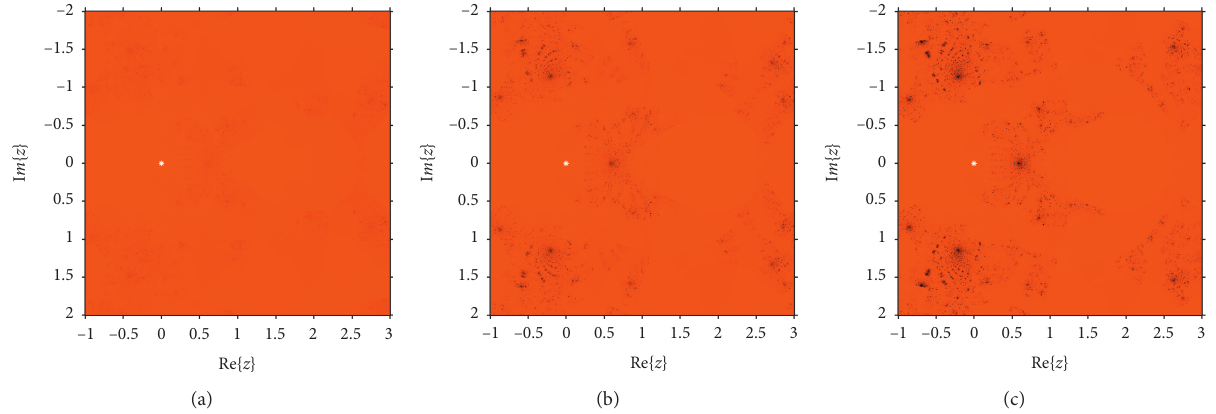
Figure 15: Basins of attraction of (a) BM1, (b) AM2, and (c) ZM3 for g